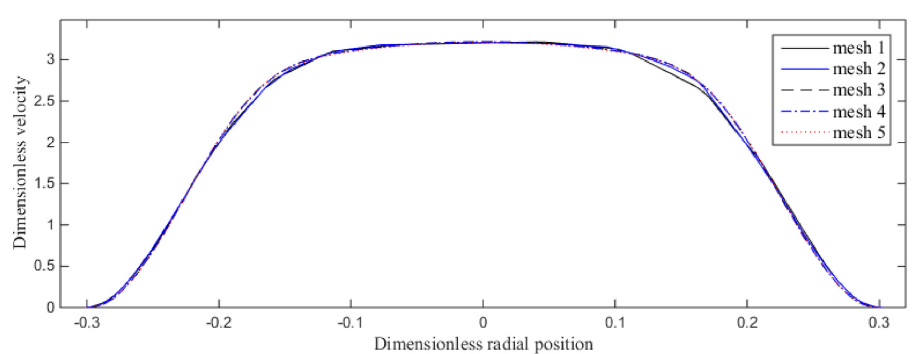
Fig 4. The dimensionless axial velocity, u at the second throat of the stenosis, x = 1 for mesh 1 = 7787, mesh2 = 10352, mesh 3 = 13998, mesh 4 = 17090 and mesh 5 = 28196.